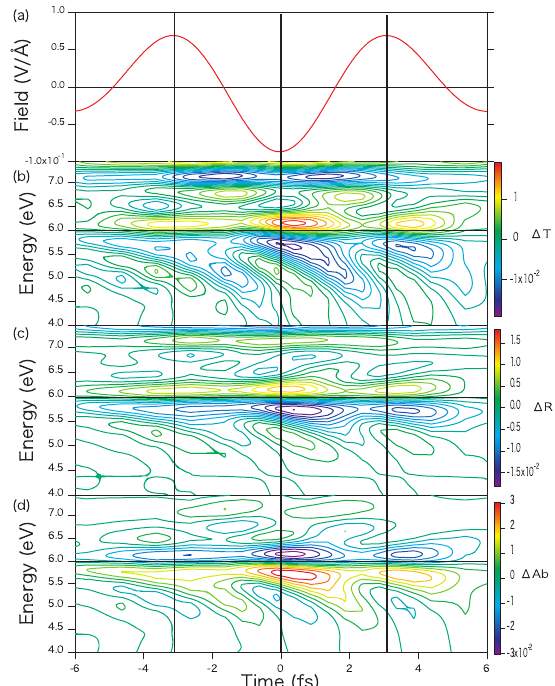
Figure 3. The laser field amplitude is shown in ( a ). Time-energy map of the ( b ) ∆ T , ( c ) ∆ R , and ( d ) ∆ R under the pump laser intensity of 1 × 10 11 W/cm 2 . The time 0 is set to the peak of the laser intensity at diamond surface. The vertical solid lines present the peak of the field amplitude.